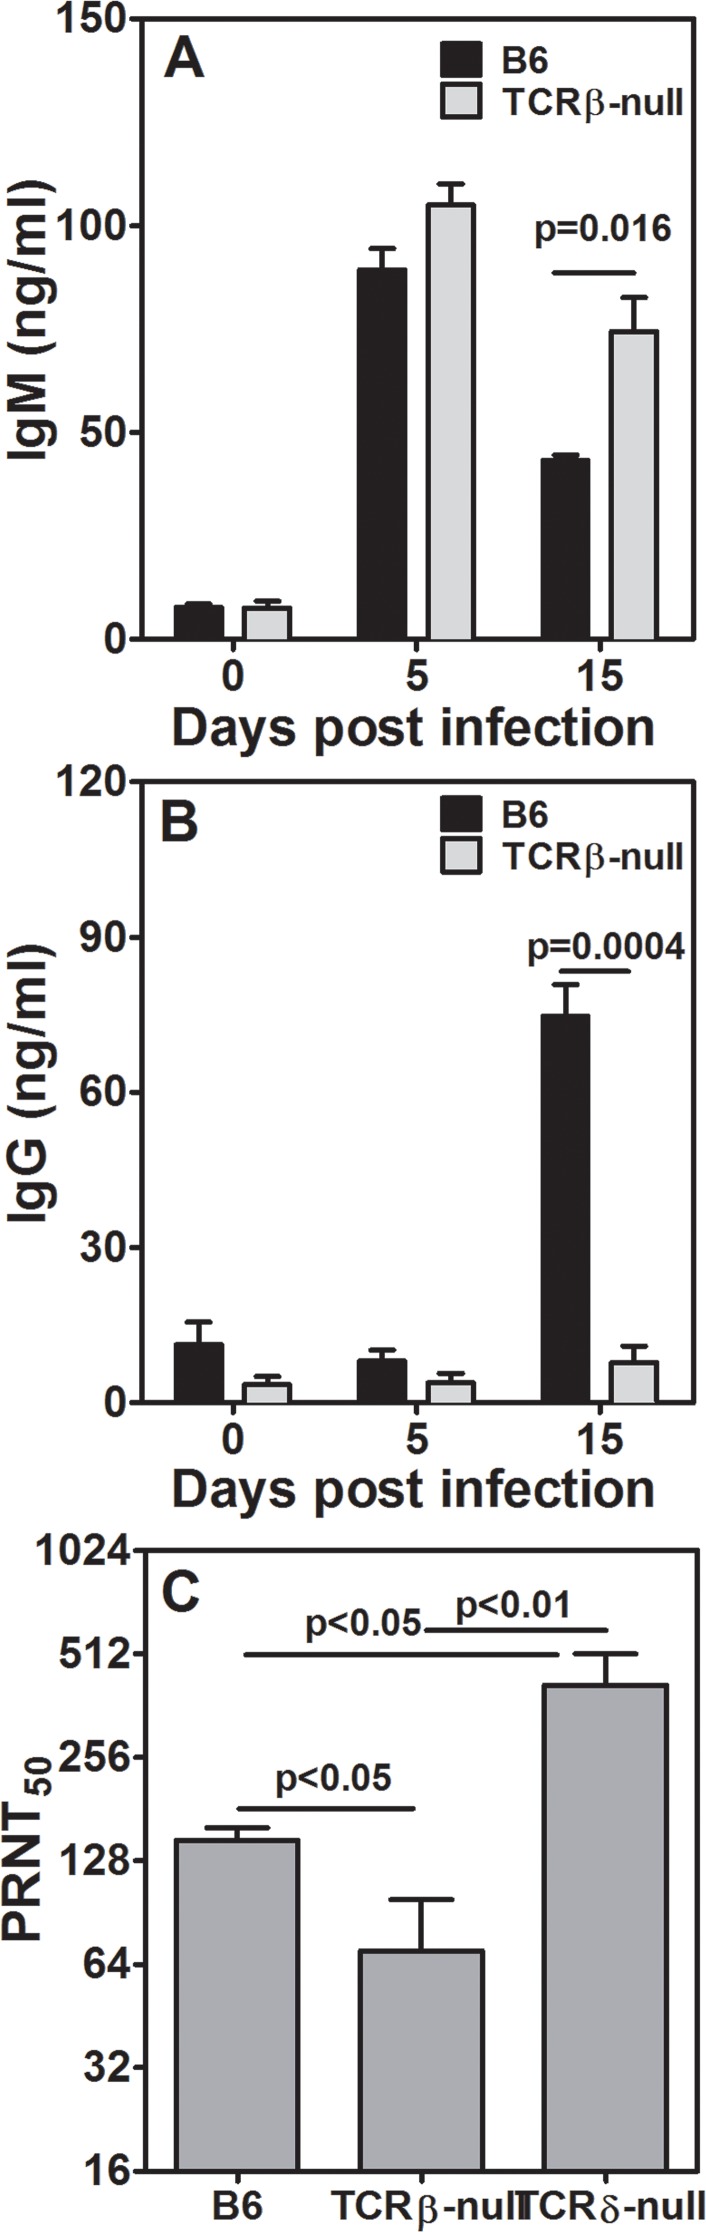
JEV-specific IgM, IgG and neutralizing antibody levels.[A] JEV-specific IgM levels in WT B6 and TCRβ-null mice prior to (day 0) and post-infection on indicated days. n = 6 mice. [B] JEV-specific IgG levels in WT B6 and TCRβ-null mice prior to (day 0) and post-infection on indicated days. n = 6 mice. [C] Virus neutralization titers (PRNT50) in infected WT B6, TCRβ-null and TCRδ-null shown as reciprocal log 2 values. n = 5 mice per group.